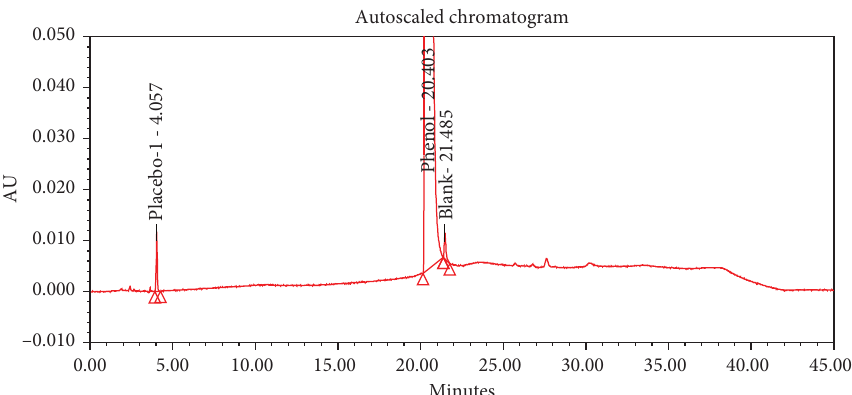
Figure 3: Chromatogram of placebo solution of neostigmine methylsulfate